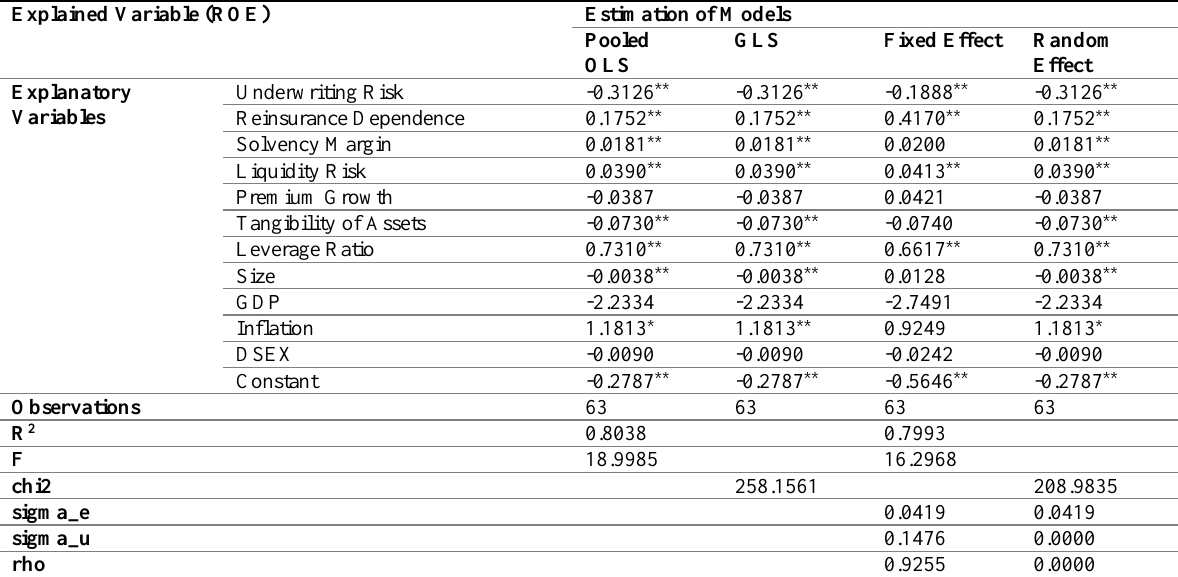
Table 4: Summary of the output of Estimated Coefficients of models based on equation 04, 05 and 06